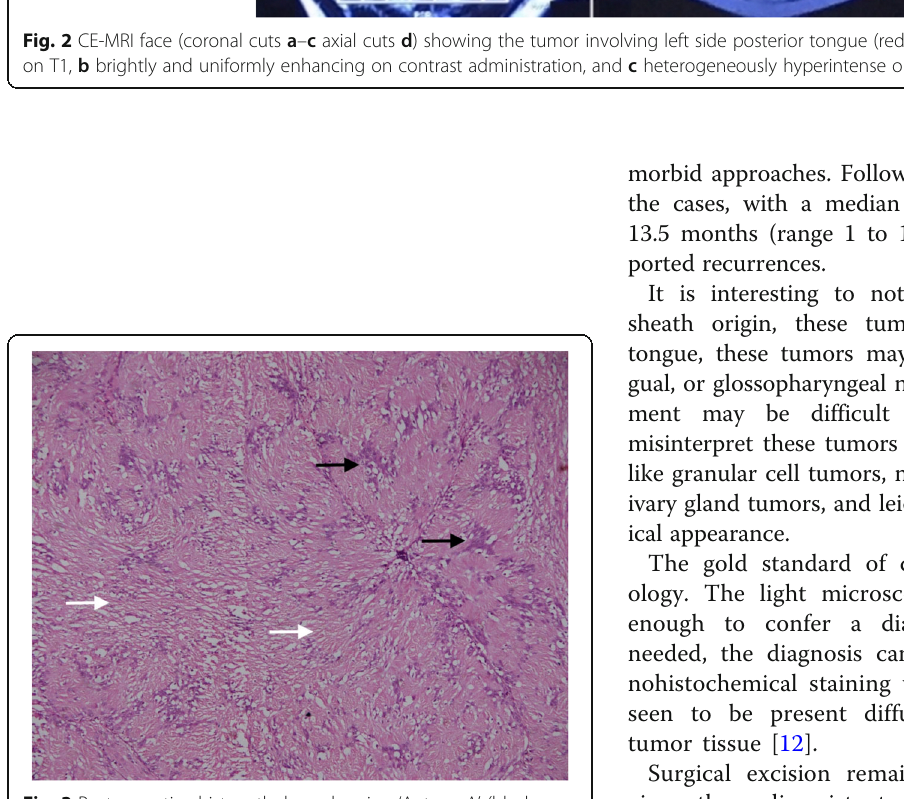
Fig. 3 Post-operative histopathology showing ‘ Antony A ’ (black arrows) and ‘ Antony B ’ (white arrows) areas characteristic of Schwannoma. (hematoxylin and eosin stain; original magnification ×